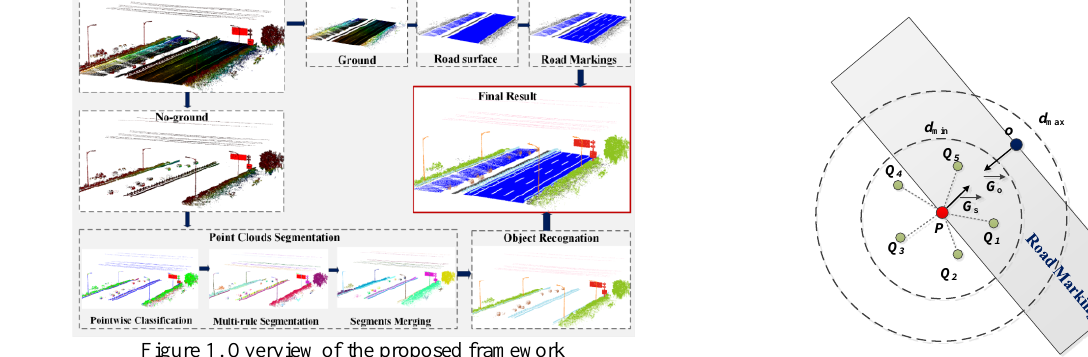
Figure 3. The diagram of road marking